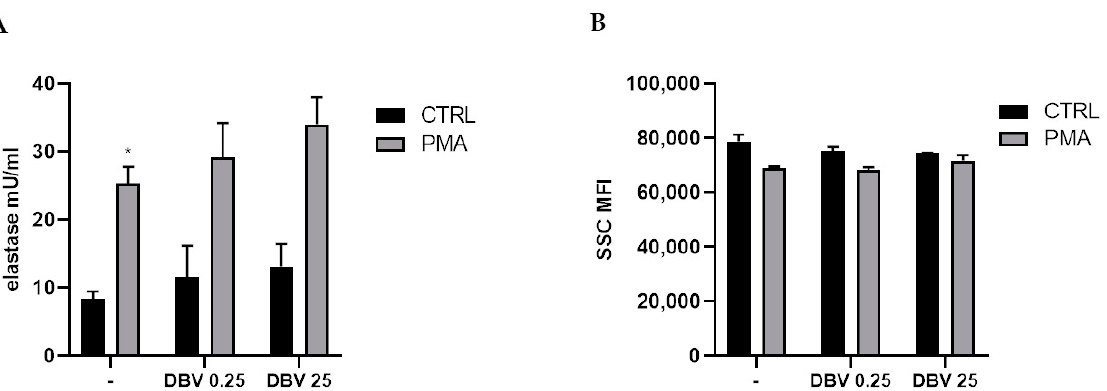
Figure 4. Effect of DBV on NETosis and degranulation. ( A ) To measure NETs production, PMNs were stimulated for 4 h with PMA (100 nM) after pretreatment with DBV (0.25 and 25 μ g/mL). NETs were measured as NET-associated elastase. ( B ) PMNs were stimulated for 60 ′ with DBV (0.25 and 25 μ g/mL) and then activated with PMA (100nM) for 30 ′ . The degree of granularity was evaluated by FACS analysis in the side scatter channel (SSC) as MFI. Values are means ± SEM of at least three independent experiments. * p < 0.05 vs. CTRL.